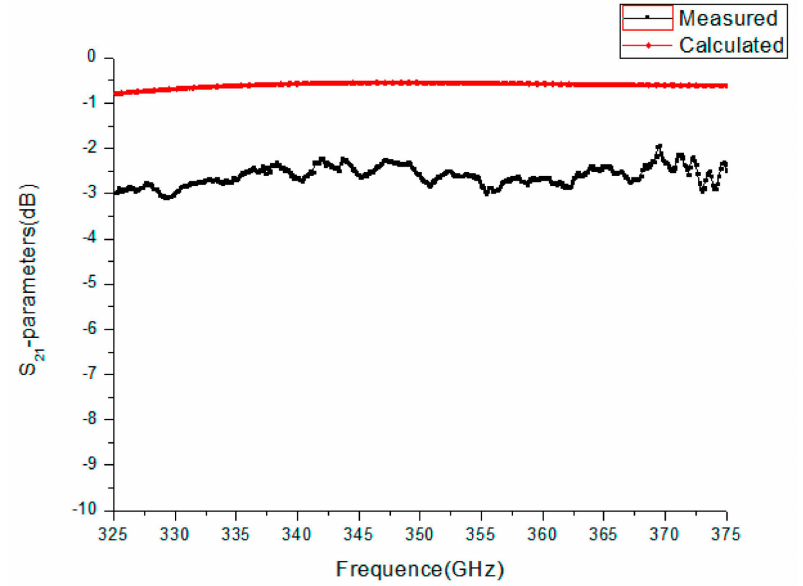
Figure 15. The experimentally measured S 21 and calculated S 21 parameters of the WR2.8